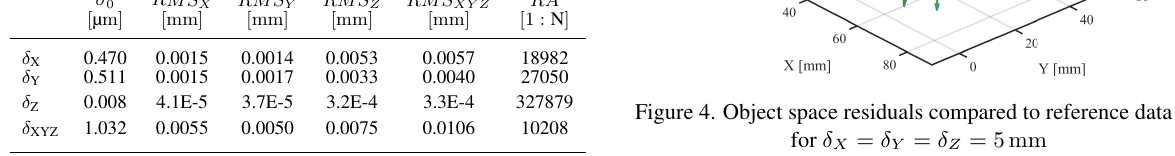
Figure 4. Object space residuals compared to reference data set for δ X = δ Y = δ Z = 5